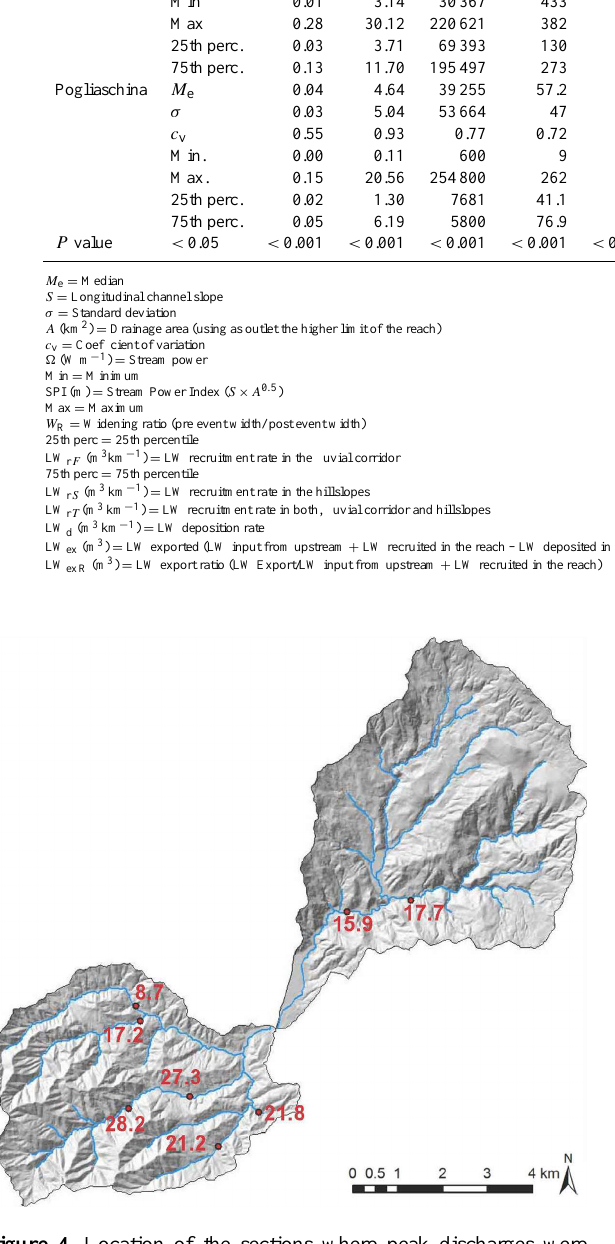
Figure 4. Location of the sections where peak discharges were measured with a red point and the value of peak discharge, in m 3 s − 1 km − 2 , are indicated in the labels. The surveyed sections are located in the following channels Veppo, Gravegnola, Pogliasca, Benoia, Redarena, Cassana, and